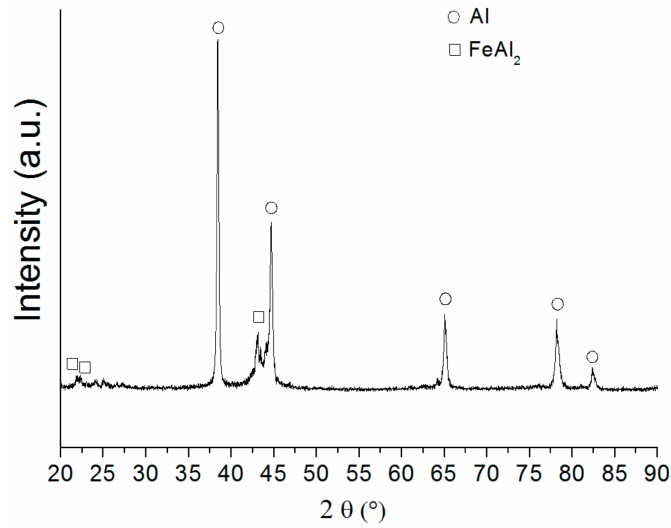
Figure 2. XRD pattern of the bimetallic Al/Fe nanoparticles. Depending on the reaction conditions of the water interaction with the bimetallic Al/Fe nanoparticles, nanostructures with different morphologies were formed. Interacting in water at 60 ◦ C, agglomerates were formed; these were up to 2 µ m in size and consisted of nanosheets 2–5 nm thick and up to 200 nm wide. Nanosheets up to 150 nm in size and up to 10 nm in thickness were formed by a hydrothermal treatment. Rod-like nanoparticles up to 80 nm long and up to 100 nm in diameter were formed by oxidation in humid air at 80% relative humidity and a temperature of 60 ◦ C. The morphology of nanoparticles formed during the oxidation of bimetallic Al/Fe nanoparticles slightly differs from that of nanopar- ticles formed during the oxidation of Al nanoparticles under similar conditions [28]; the FeAl 2 intermetallide, which was present in the bimetallic nanoparticles, had no noticeable effect on the oxidation process. According to the TEM-EDS elemental analysis, iron was evenly distributed throughout the particles and the iron/aluminum ratio corresponded with that of the initial nanoparticles (Figure 3).